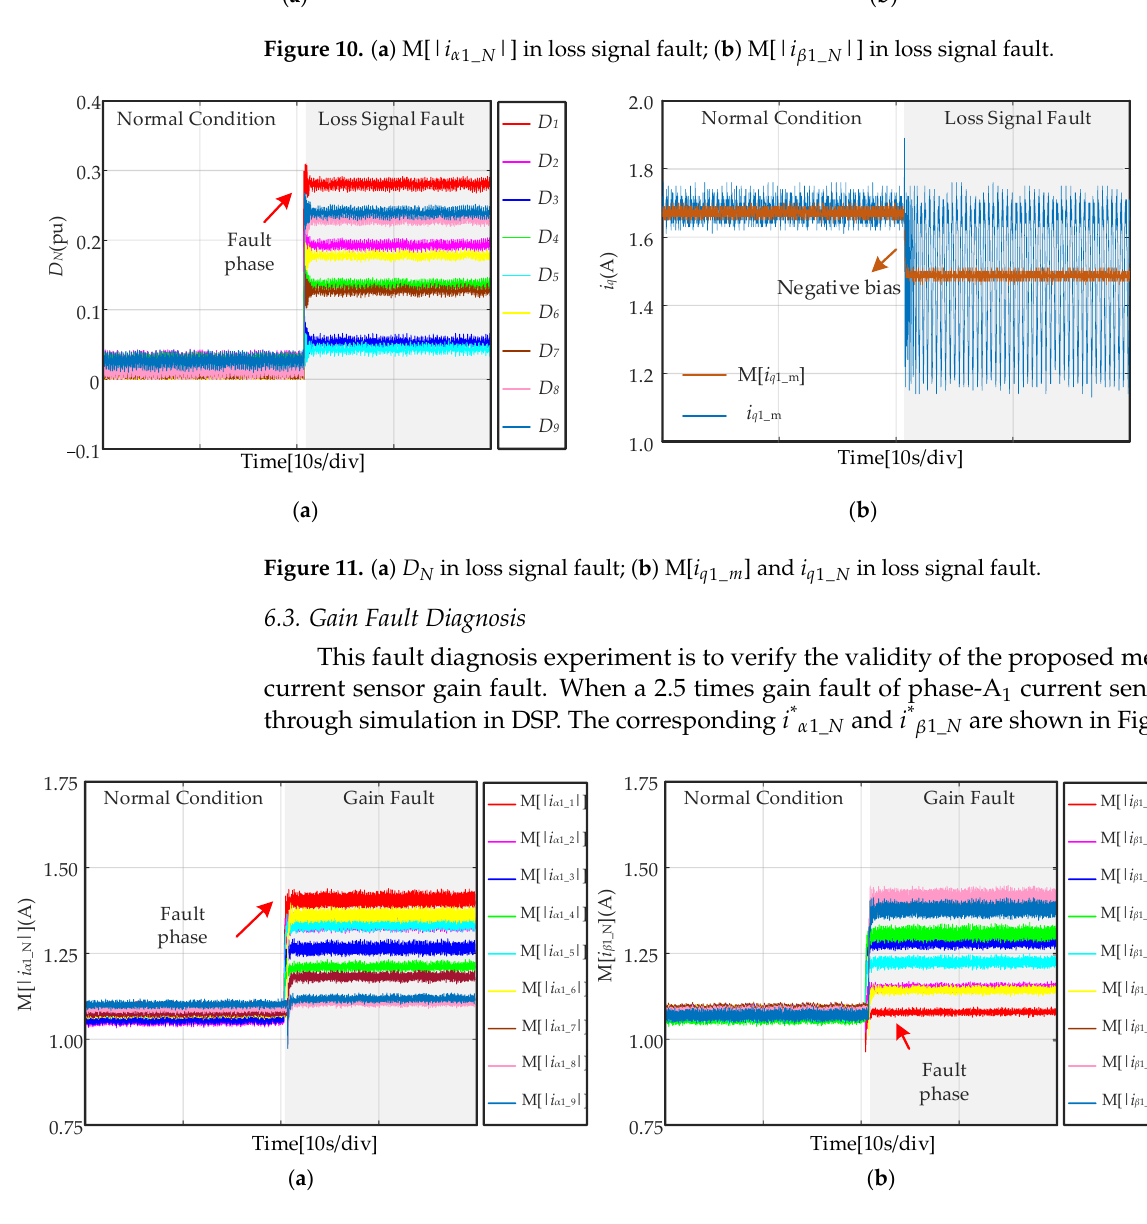
Figure 12. ( a ) M[| i α 1_ N |] in gain fault; ( b ) M[| i β 1_ N |] in gain fault. When the loss signal fault occurs in phase-A 1 ( i A1 = 2.5 i * A1 ), i α 1_1 is most affected while i β 1_1 keeps the constant amplitude. According to Equation (7), i α 1_1 becomes the current with the largest amplitude and i β 1_1 becomes the one with the smallest amplitude. The M[| i α 1_ N |] and M[| i β 1_ N |] calculated by absolute-mean processors are shown in Figure 12. Therefore, the value of M[| i α 1_1 |] is the largest of the nine M[| i α 1_ N |], and M[| i β 1_1 |] is the smallest one of the nine M[| i β 1_ N |]. Figure 13 shows the diagnosis variables D N and M[ i q 1_ m ]. Each D N are approximately zero in normal conditions. When the fault occurs, the difference between M[| i α 1_ N |] and M[| i β 1_ N |] of the fault phase is strictly maximum in Figure 13. Therefore, D 1 is also the max value of D N , so the fault phase-A 1 can be located. Moreover, i q 1 _m has a distinct positive DC bias “ 1.5 I a m sin( θ ori )/9” and a zero-mean pulse. Thus, M[ i q 1 _m ] in loss signal fault is greater than it is in normal conditions, which can be used to further diagnose tolerant control. So, the loss signal fault of phase-A 1 current sensor can be diagnosed. Fault phase Normal Condition Gain Fault 0.100.10.2 0.30.4 ( b ) Figure 13. ( a ) D N in gain fault; ( b ) M[ i q 1_ m ] and i q 1_ N in gain fault. The threshold selection is eliminated in the whole diagnosis process, and the loss signal faults can be located by selecting the phase with the maximum value of the diag- nosis variables D N . M[ i q 1_ m ] has an obvious negative bias feature, which makes the distinc- tion between loss signal and gain faults more accurate. Normal Condition